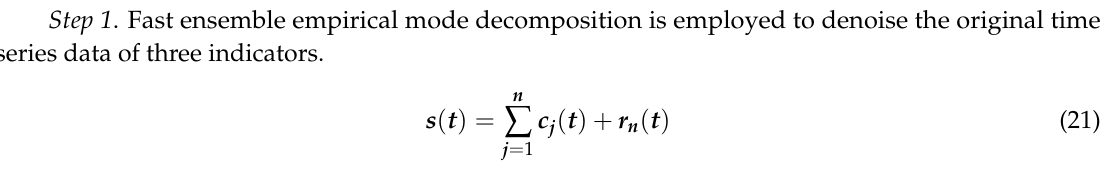
Figure 3. Flow chart of the hybrid models proposed in this paper.